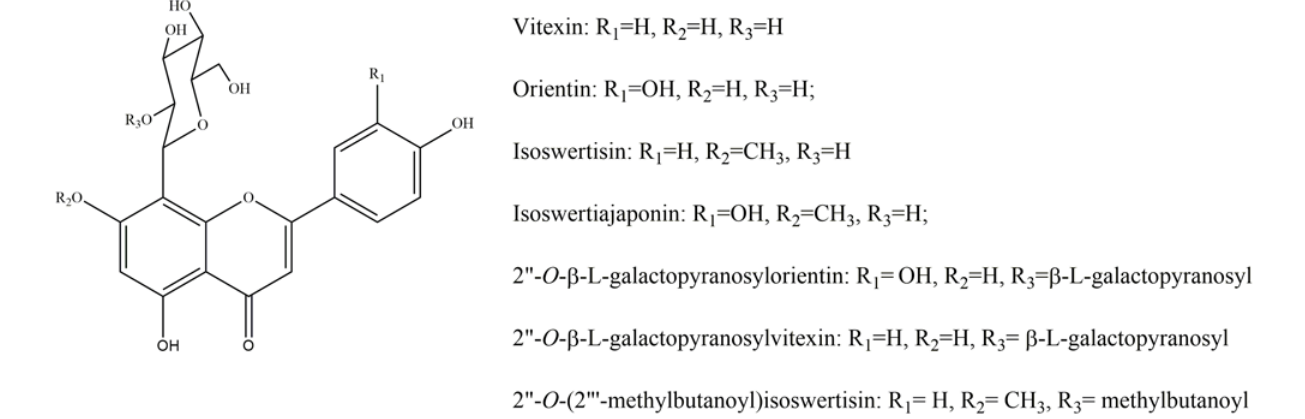
Fig 1. The structures of the seven